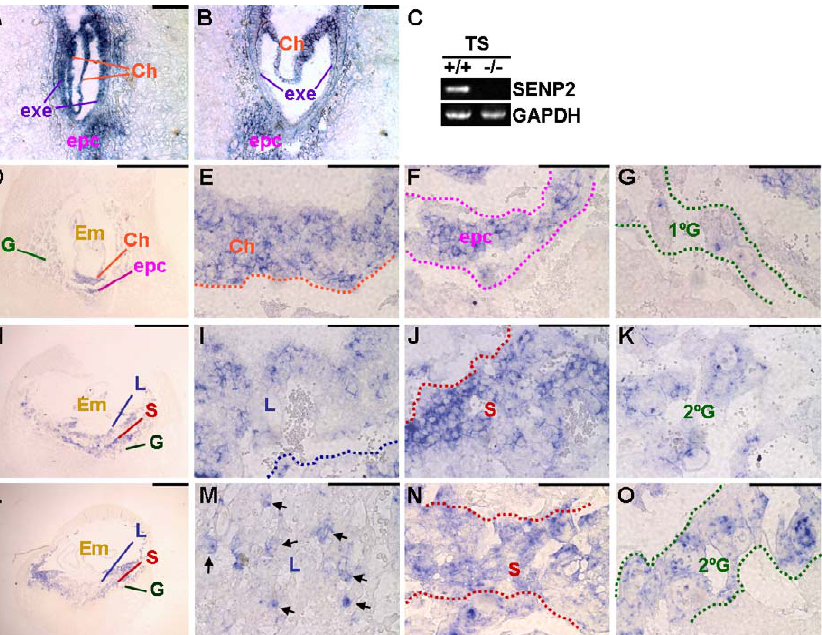
Figure 1. SENP2 Is Expressed in Trophoblast Lineage Development (A and B) In situ hybridization reveals that SENP2 is expressed in the trophoblast stem cell niches, including extraembryonic ectoderm (exe) , chorion (Ch) and ectoplacental cone (epc) at E7.0 (A) and E7.5 (B). (C) RT-PCR analysis detected the SENP2 transcript in wild-type ( þ / þ ), but not knockout (–/–) TS cells. (D–O) Sections of the E8.5 (D–G), E9.5 (H–K) and E10.5 (L–O) placentas were analyzed by in situ hybridization for the expression of SENP2 . Expression was detected in major extraembryonic tissues. Low magnification images display the overall expression pattern in developing placentas (D,H,L). High magnification images show expression in specific cell types and layers (E–G,I–K,M–O). The chorion, ectoplacental cone, labyrinth (L), spongiotrophoblast (S), and TGC (G; 1 8 , primary; 2 8 , secondary) layers are defined by orange, pink, blue, red, and green broken lines, respectively. Arrows indicate specific expression in mononuclear trophoblasts (cytotrophoblasts) of the labyrinth layer (M). Em, embryo. Scale bars, 1 mm (D,H,L); 100 l m (A,B,E–G,I–K,M–O).